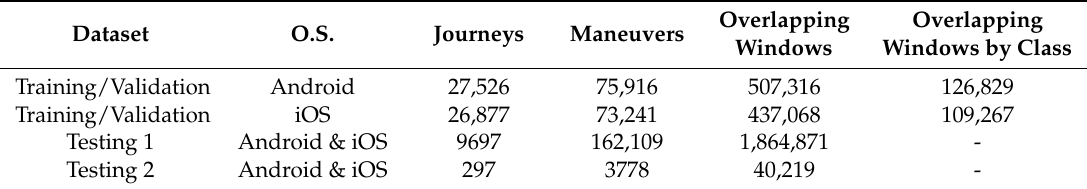
Table 1. Number of journeys, maneuvers and overlapping windows used for the acceleration forces characterization, by operating system and dataset.